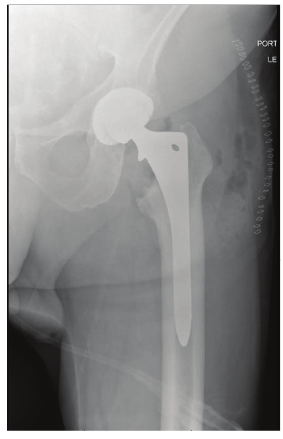
Figure 5: AP hip postoperatively showing no fracture or femoral cortex perforation.